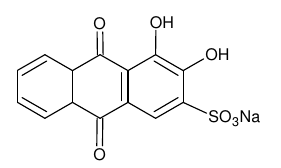
Figure 3. Chemical structure of alizarin red